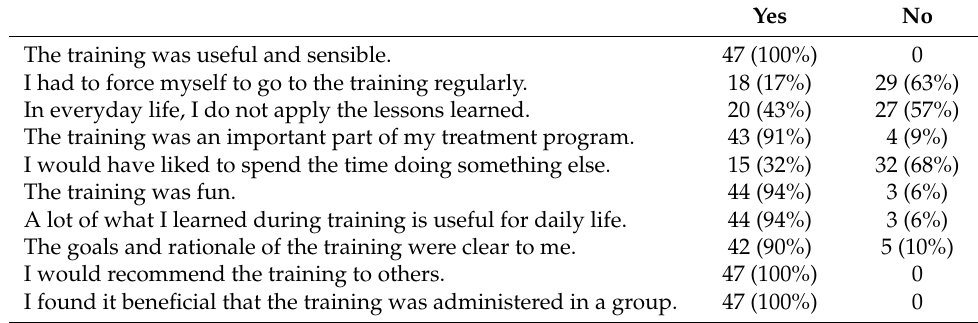
Table 4. Subjective assessment of the MCT interventions at post-treatment ( n =